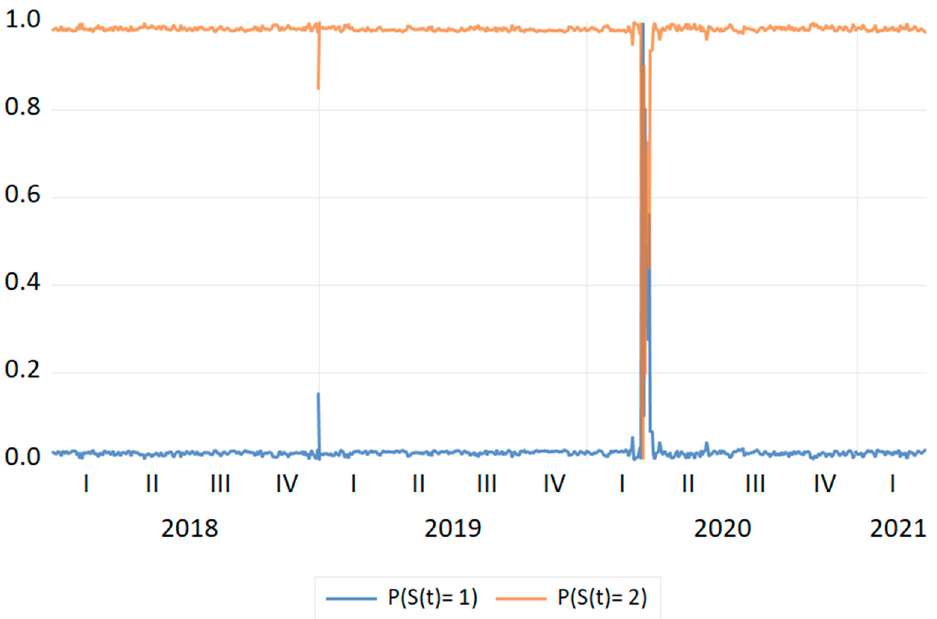
Figure 7. Regime smoothed probabilities. Figure 8. Regime smoothed